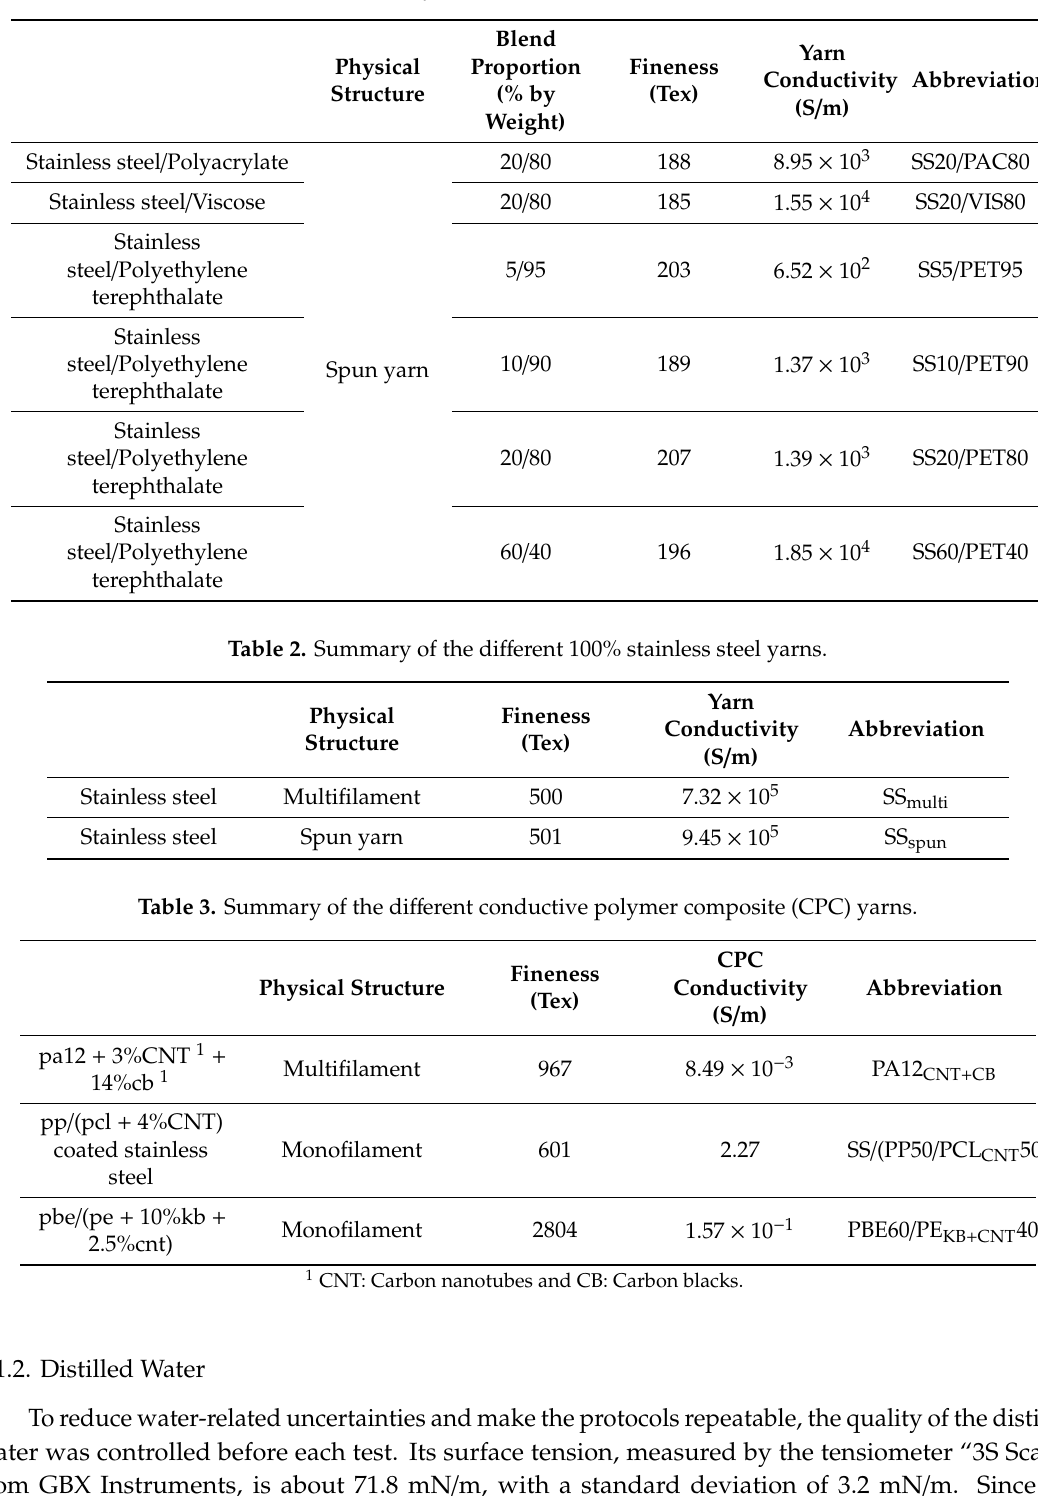
Table 1. Summary of the di ff erent stainless steel blends.